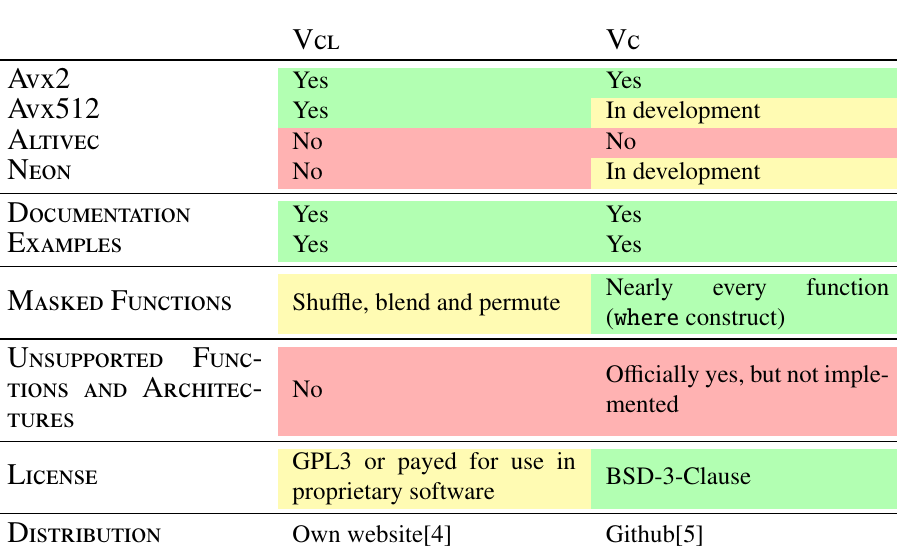
Table 1: Vectorisation